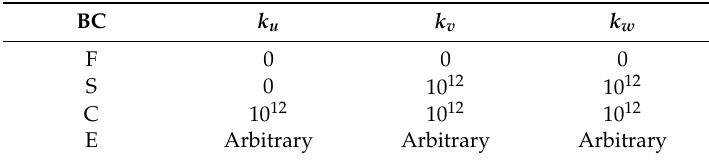
Table 1. Values of spring sti ff ness taken by di ff erent boundary conditions